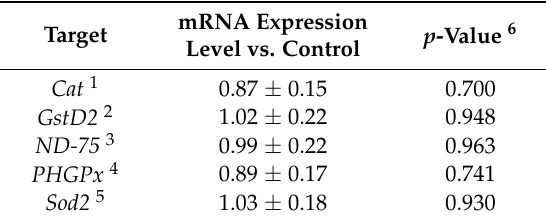
Table 2. Relative mRNA expression of antioxidant enzymes in female w 1118 D. melanogaster in dependence of resveratrol (RESV; 500 µmol/L) administration for ten days compared to controls. mRNA Expression Target p -Value 6 Level vs. Control Cat 1 0.87 ± 0.15 0.700 GstD2 2 1.02 ± 0.22 0.948 ND-75 3 0.99 ± 0.22 0.963 PHGPx 4 0.89 ± 0.17 0.741 Sod2 5 1.03 ± 0.18 0.930